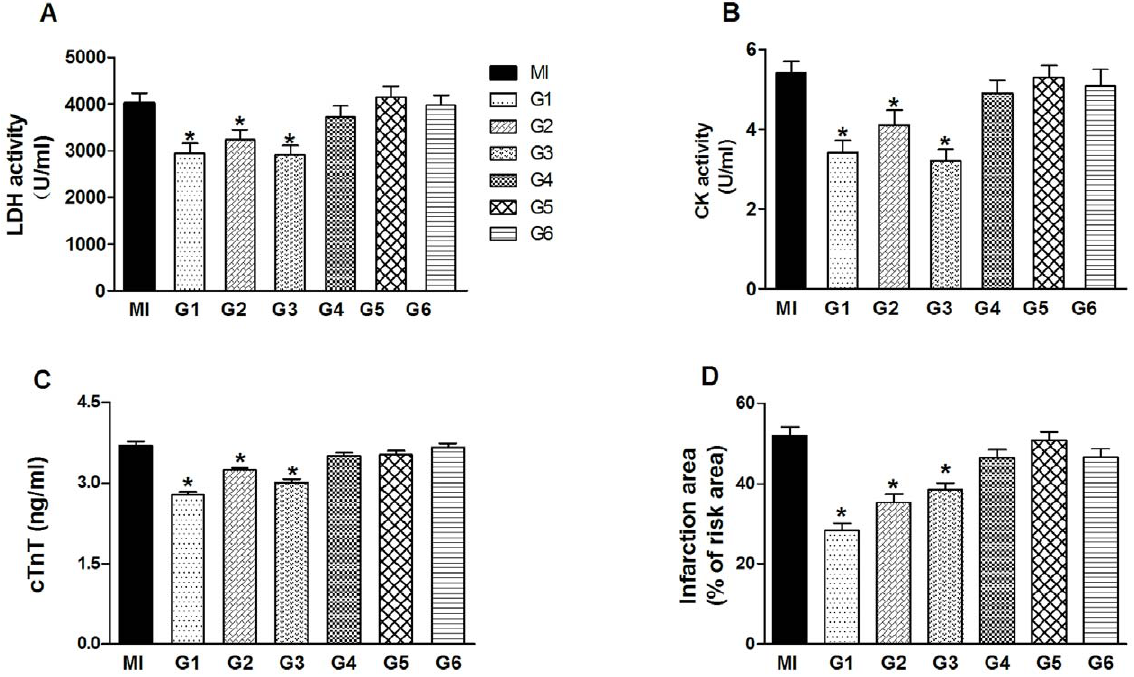
Figure 4. Effects of vagal stimulation on serum enzyme activity and infarction size following acute myocardial infarction in MI and G1–G6 group. (A) Lactate dehydrogenase (LDH), (B) creatine kinase (CK), (C) cTnT activity in the serum (n=8 for each group). (D) Changes of myocardial infarction size (percentage risk area) by VNS. (n=8 for each group). Data are expressed as mean 6 SEM Data are the mean 6 SEM. * P , 0.05 compared with MI control